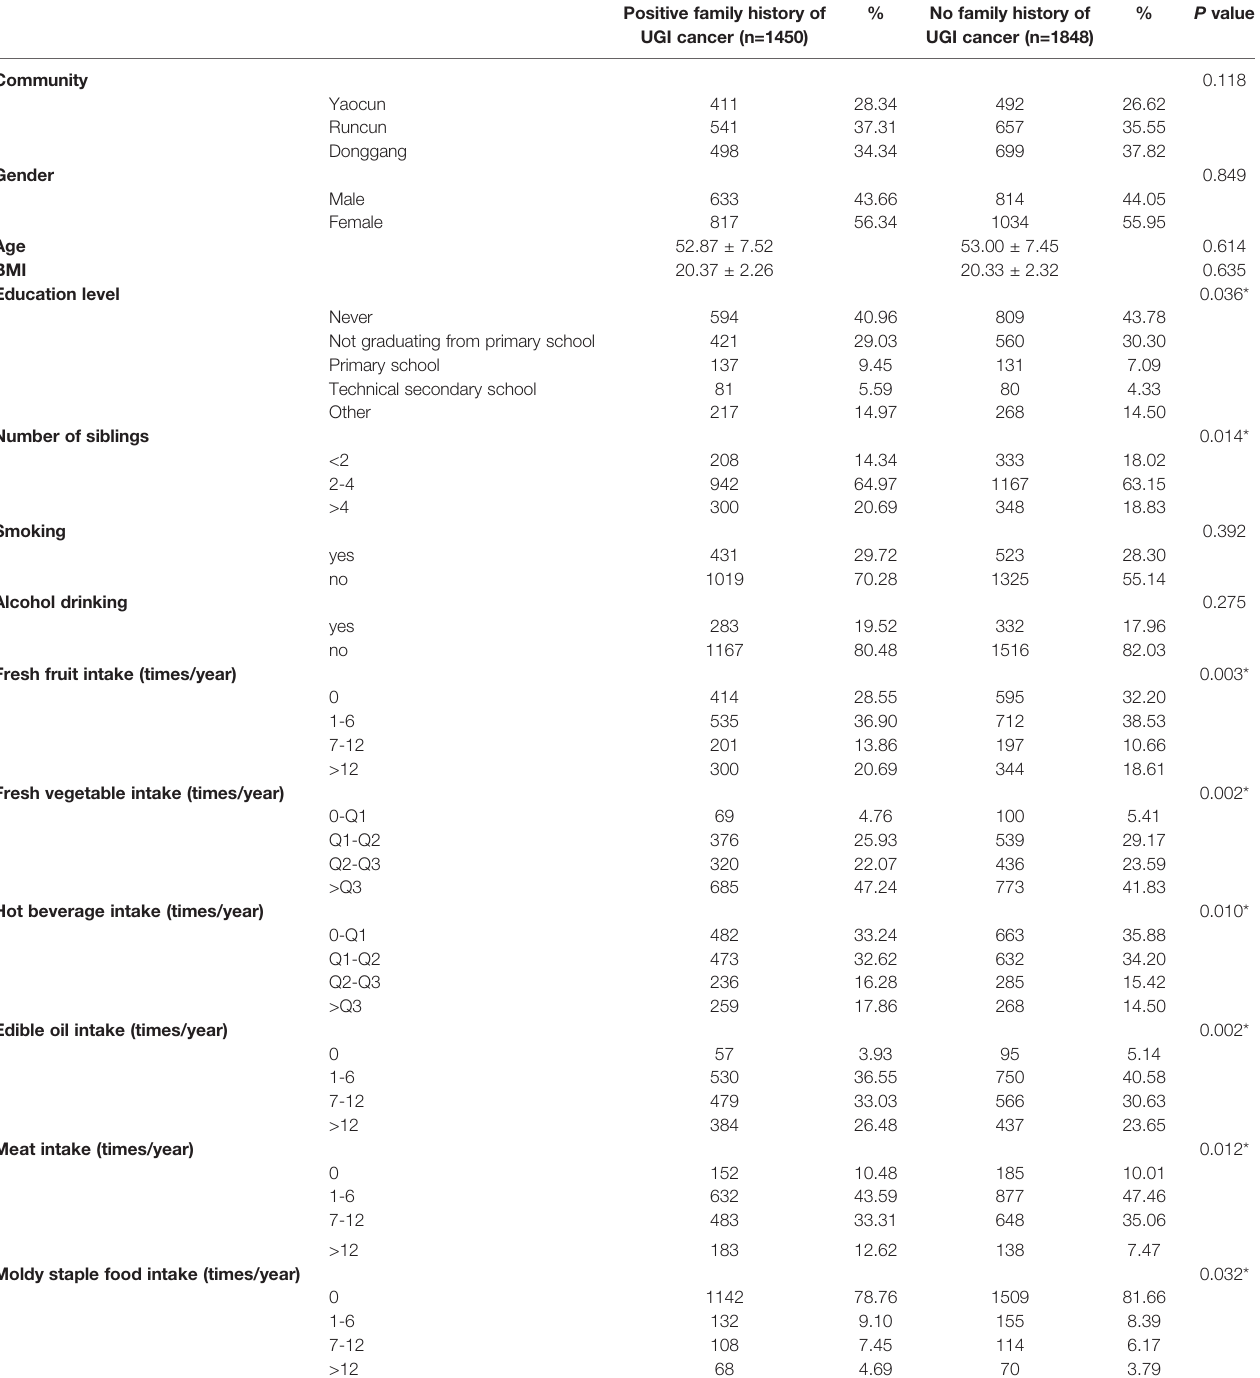
TABLE 1 | Basic demographic characteristics and lifestyle of the studied